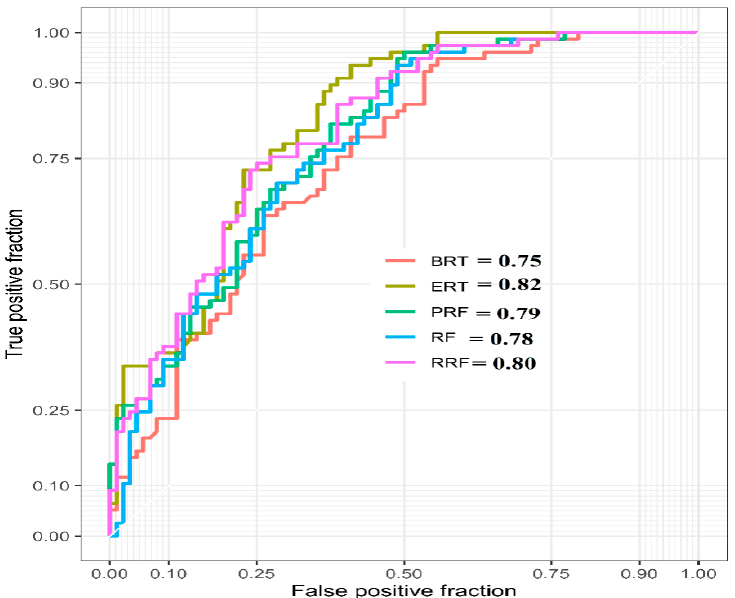
Table 3. Predictive capability of piping models using train and test dataset.